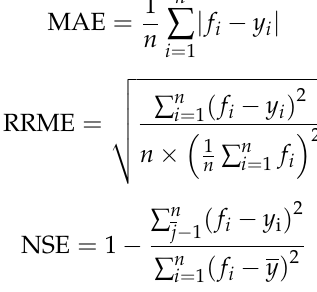
Figure 7. Plot of the water head horizontally along the pipe for different mesh sizes.